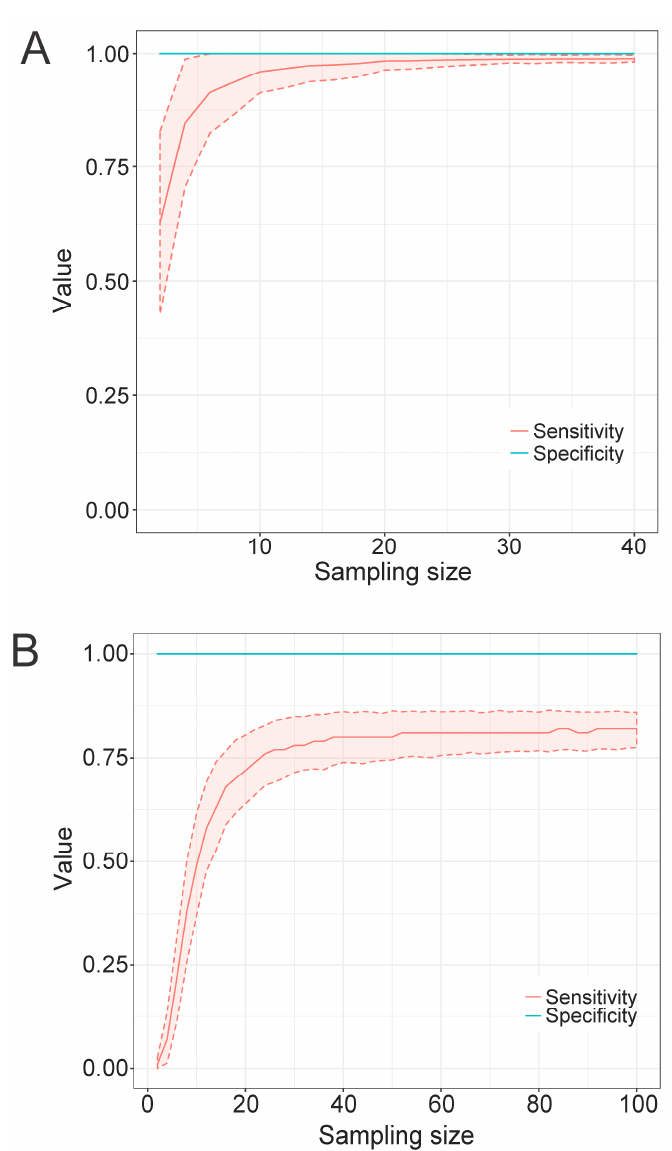
Figure 4. The effect of sequence sampling size on the performance of profile HMMs constructed with TABAJARA. A DENV-specific alignment region (coordinates 10–117), derived from an MSA composed of 6364 Flavivirus polyprotein sequences, was selected. A second test was performed with a Gokushovirinae -specific alignment region (coordinates 2240–2339), derived from an MSA composed of 1866 Microviridae VP1 sequences comprising Alpavirinae , Gokushovirinae and Pichovirinae representatives. Alignment blocks covering the selected regions, composed of an n number of randomly sampled taxon-specific sequences, with 1000 pseudoreplicates for each n value, were used to construct profile HMMs. All DENV-derived models were tested with hmmsearch program against a bona fide dataset of 6364 Flavivirus ( A ) sequences comprising a wide variety of viral species. For Microviridae ( B ), profile HMMs were validated against a bona fide dataset of 1866 VP1 sequences, comprising members of three subfamilies of the family. In all tests, the datasets were specifically depleted of the DENV or Gokushovirinae sequences used to construct the respective evaluated models. Sensitivity and specificity lines, using cutoff scores ascribed by TABAJARA, represent arithmetic means calculated from the combined results of models generated with the pseudoreplicates of each sampling size. Shaded areas indicate standard deviation values.